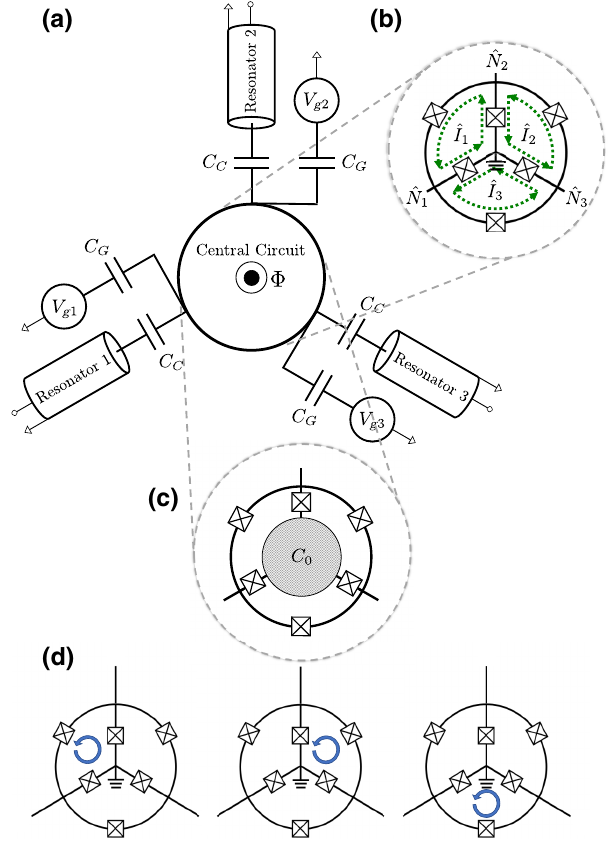
FIG. 1. (a) Schematic representation of the model with a generic central circuit threaded by external flux (cid:2) via an external magnetic field applied perpendicular to the plane. Each resonator and voltage source V gi is coupled to an island of the central circuit via capacitors C C and C G , respectively. (b) The central circuit model, with identical Josephson junctions (cid:2) having Josephson energy E J and capacitance C J , with labeled loop currents through each third of the model: ˆ I 1 , ˆ I 2 , and ˆ I 3 . (c) An alternative cir- cuit design (explored in Appendix A) that replaces the central ground with a large central island with self-capacitance C 0 . (d) The persistent-current vortices that may exist in each third of the